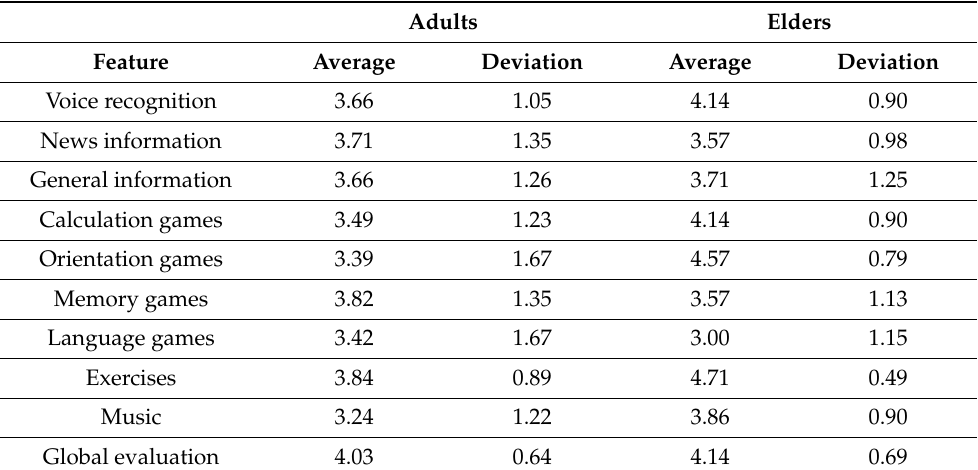
Table 3. Results of the robot features evaluation.